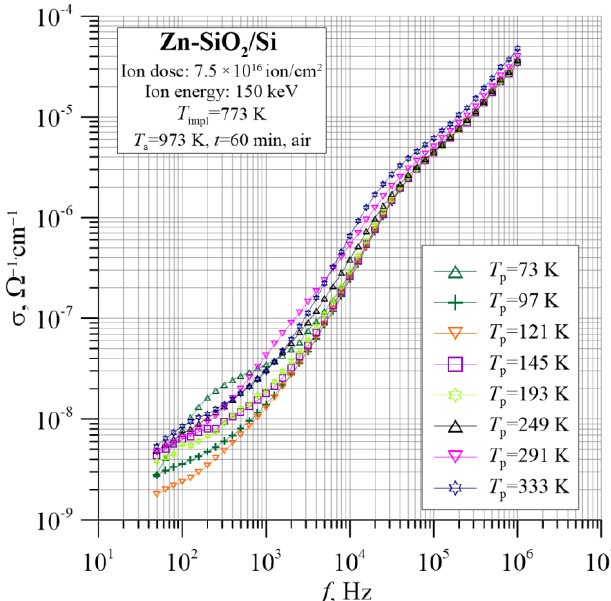
Figure 10. Temperature – frequency dependence of the conductivity σ ( f , T p ) for the Zn-SiO 2 /Si nanocomposite prepared under “ hot ” implantation conditions (150 keV, 7.5 × 10 16 ion/cm 2 , T impl = 773 K) after annealing.